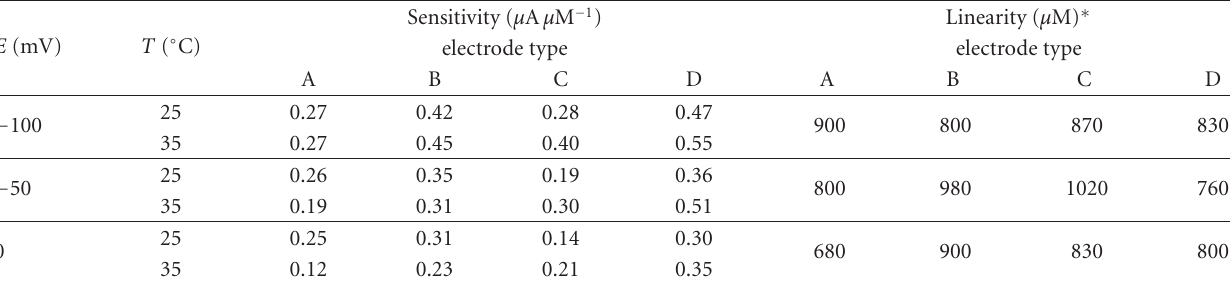
Table 1: Electrode sensitivities (determined from the linear portions of the calibration graphs at temperatures 25 and 30degree, correlation coe ffi cients ranging between 0.98 and 0.99) and linear dynamic ranges of GC electrodes modified with microquantities of (Pd+Au) mixtures during hydrogen peroxide electrochemical reduction; temperatures 25 and 35 ◦ C; phosphate-citrate bu ff er pH 7.0; reference electrode Ag/AgCl (1MKCl).